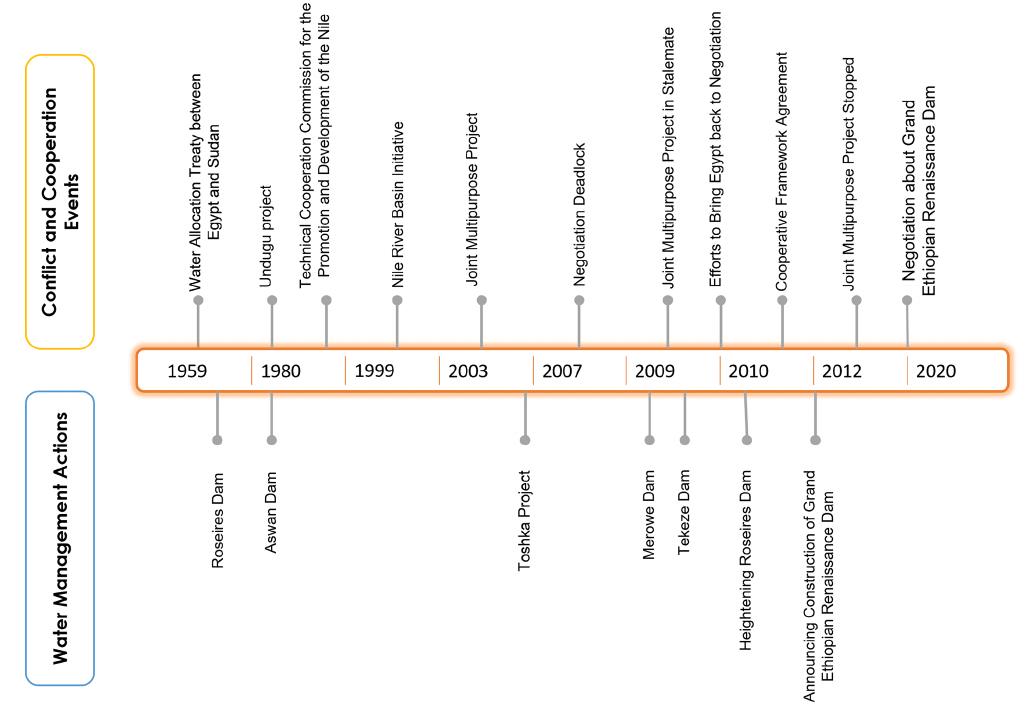
Figure 2. Timeline of conflict-and-cooperation events and water management actions in the Nile River basin, with a particular focus on the three riparian countries of Egypt, Sudan, and